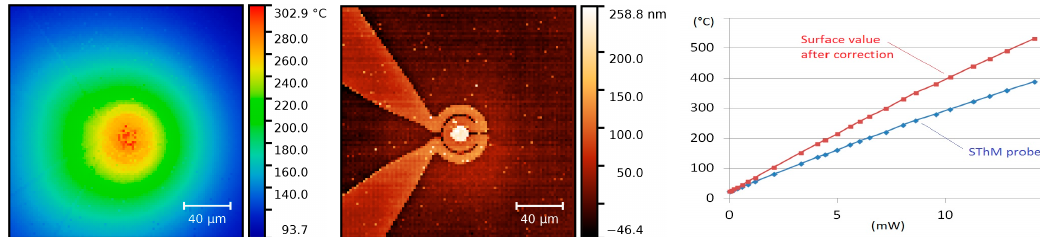
Figure 3. 1st Design; ( left ) surface temperature distribution by SThM; ( middle ) SThM topography; ( right ) temperature at the center versus power.